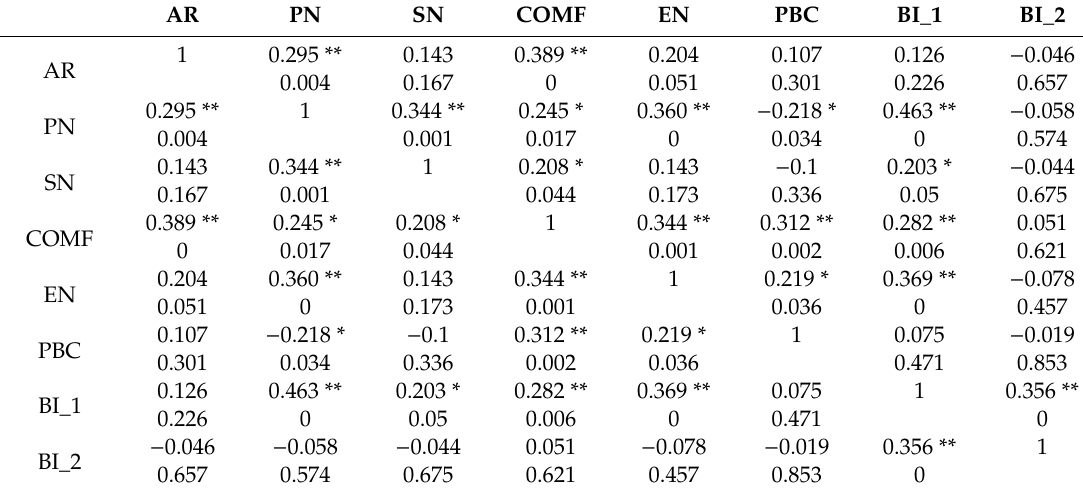
Table 14. Correlation analysis